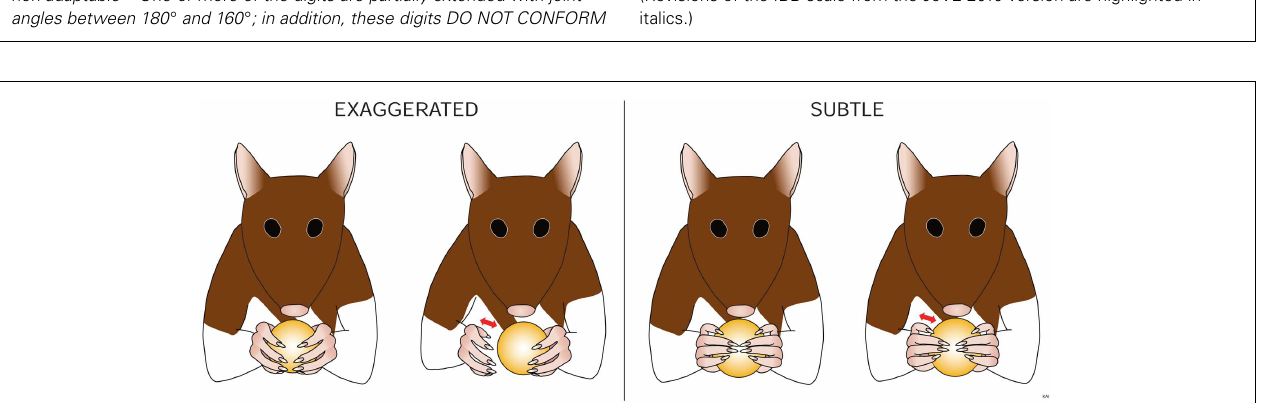
FIGURE 7 |Amendment: cereal adjustments (control) .The rat is assessed for movements made by the impaired forelimb that are synchronized in time with successful manipulatory movements of the unimpaired forelimb, and that contribute to the proper manipulation of the cereal.These cereal adjustments can be defined as either: none – there are NO cereal adjustments made by the impaired forelimb. Exaggerated – movements by the shoulder and/or elbow and/or wrist of the impaired forelimb that cause a loss of contact between the volar surface of the impaired forepaw and the cereal, which DO NOT adjust (control) the cereal position or DO NOT contribute to the proper